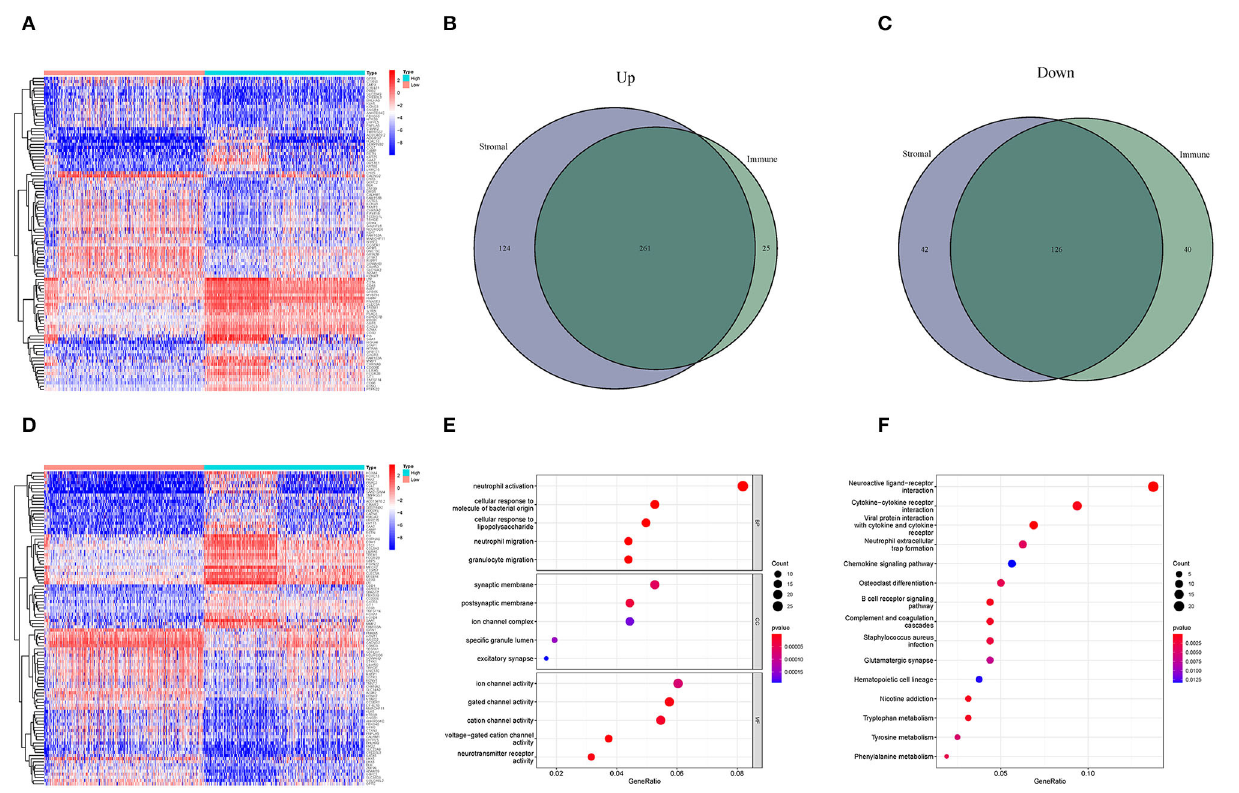
FIGURE 3 | Heatmaps and the interaction of DEGs, GO, and KEGG analyses. (A,D) Heatmaps for DEGs were generated by comparing the high-score group vs. the low-score group. The row name is the gene, and the column name is the sample ID, not shown in the image. DEGs were identified by Wilcoxon rank-sum test with FDR < 0.05 and | log 2 FC (fold-change) | > 1. (A,D) Represent the immune and stromal scores, respectively. In the two heatmaps, only 50 DEGs are shown. (B) Interaction of upregulated DEGs with immune score and stromal score. (C) Interaction of downregulated DEGs with immune score and stromal score. (E,F) GO and KEGG enrichment analyses for 452 DEGs; p < 0.05 were speculated to be enriched